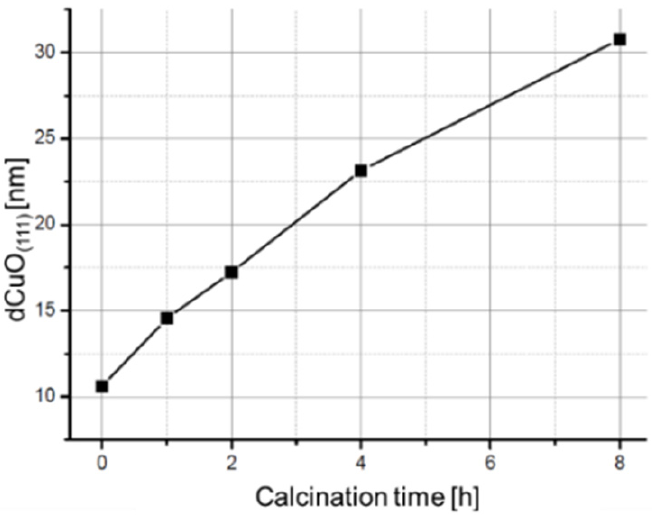
Figure 14. Calculated crystallite size dCuO (111) depending on the calcination time at a calcination temperature. Catalyst system: Cu 0.61 Zn 0.21 Al 0.18 , h equ = 600, T calc = 823 K, heating rate = 1 K · min − 1 . To rationalize the influence of the calcination temperature and duration on the methanol